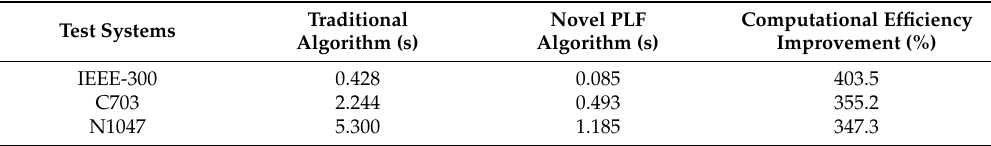
Table 2. Computational time for the cumulants calculating process only.